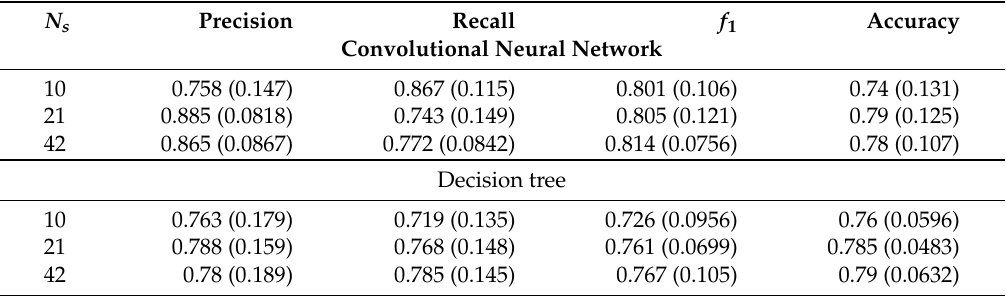
Figure 16. Results for anomaly classification using convolutional neural network. Best case: N s = 42. ( a ) Bar plots of anomaly classification values for five-fold cross validation. ( b ) Bar plots of anomaly classification values for leave-one-out cross validation. Table 3. Comparison of leave-one-subject-out cross validation results for deep-learning-based anomaly classification using all features as input and tree-based classifier (four